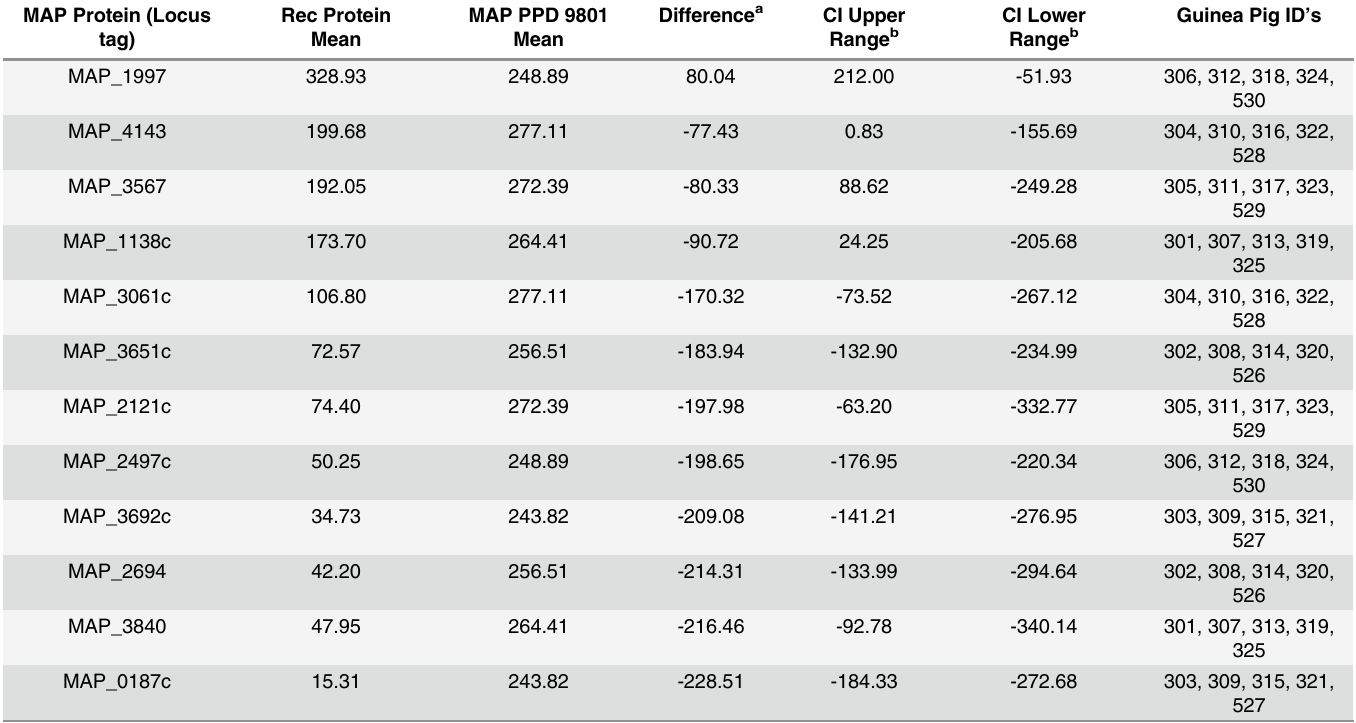
a Differences were calculated by subtracting the MAP protein skin test response from the PPD skin test response for each animal and then averaging the calculated differences for all animals in each treatment group. b Upper and lower range values represent 95% con fi dence interval (CI)